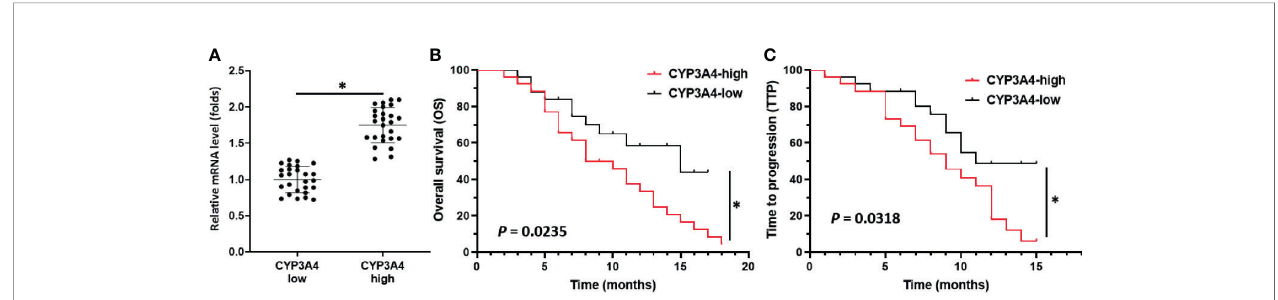
FIGURE 1 | High levels of cyp3a4 is associated with poor prognosis in advanced HCC. (A) The endogenous mRNA levels of cyp3a4 were assessed in 52 clinical specimens from patients with advanced HCC. According to the median expression level of cyp3a4 in HCC tissue samples, patients were divided into two groups: a cyp3a4 high expression group [ cyp3a4 -high] and a cyp3a4 low expression group [ cyp3a4 -low]) (B , C) . Survival analysis included analysis of TTP and OS. *P <